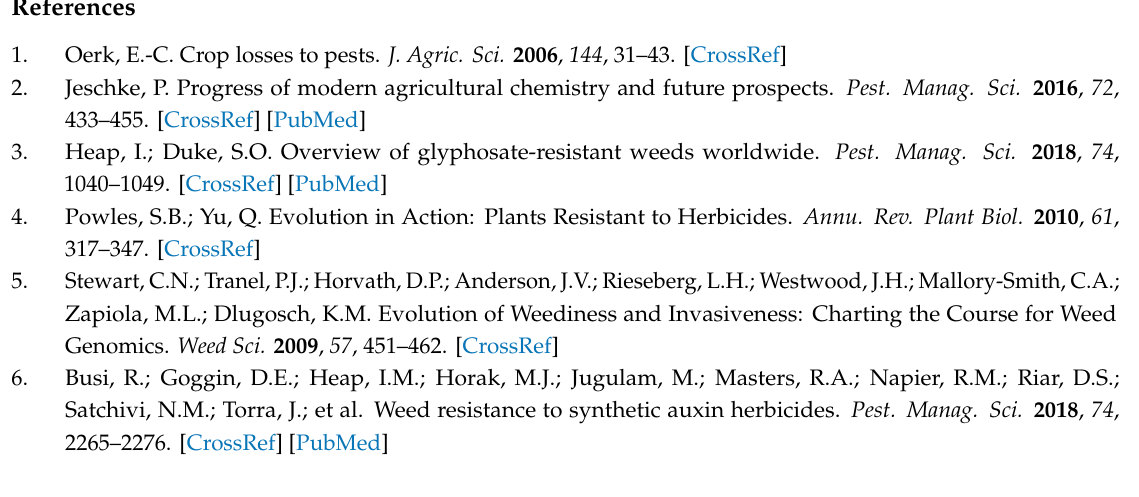
Table S1: The simple qualitative e ff ect of separating the cellular damage as a response to saflufenacil treatment in glyphosate-resistant (GR) and -sensitive (GS) biotypes of Conyza bonariensis as a function of time after treatment and rate; Table S2: The simple qualitative e ff ect of separating the cellular damage as a response to glyphosate treatment in glyphosate-resistant (GR) and -sensitive (GS) biotypes of Conyza bonariensis as a function of time after treatment and rate; Table S3: The simple qualitative e ff ect of separating the cellular damage as a response to glyphosate (1480 g ae ha -1 ) combined with saflufenacil treatment in glyphosate-resistant (GR) and -sensitive (GS) biotypes of Conyza bonariensis as a function of time after treatment and rate; Table S4: Regression, root mean square error (RMSE), and determination coe ffi cient (R 2 ) for the polynomial model from evaluated variables (shikimic acid, H 2 O 2 , and TBARS) extracted from Conyza bonariensis as a function of biotype (GR and GS), rate of saflufenacil, and time after treatment; Table S5: Regression, root mean square error (RMSE), and determination coe ffi cient (R 2 ) for the polynomial model from evaluated variables (shikimic acid, H 2 O 2 , and TBARS) extracted from Conyza bonariensis as a function of biotype (GR and GS), rate of glyphosate, and time after treatment; Table S6: Regression, root mean square error (RMSE), and determination coe ffi cient (R 2 ) for the polynomial model from evaluated variables (shikimic acid, H 2 O 2 , and TBARS) extracted from Conyza bonariensis as a function of biotype (GR and GS), rate of saflufenacil combined with glyphosate (1480 g ae ha -1 ), and time after